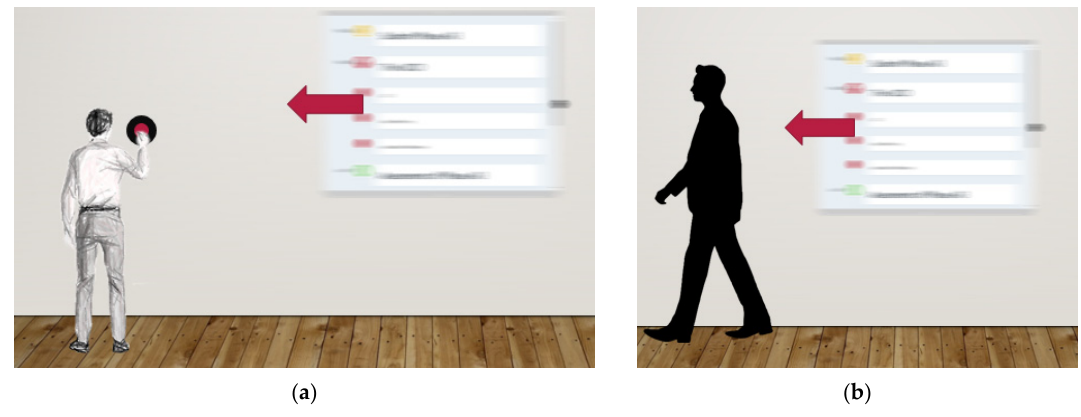
Figure 10. ( a ) Summon tool. ( b ) Follow-Me tool. Technologies 2020 , 8 , x FOR PEER REVIEW